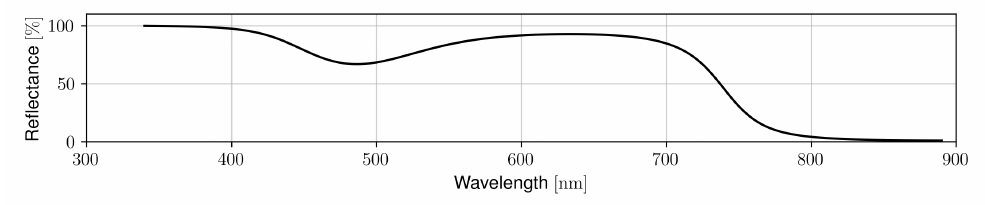
Figure 11. Spectral reflectance of Calsphere 4A estimated from spectral upsampling based on the albedo values in Table